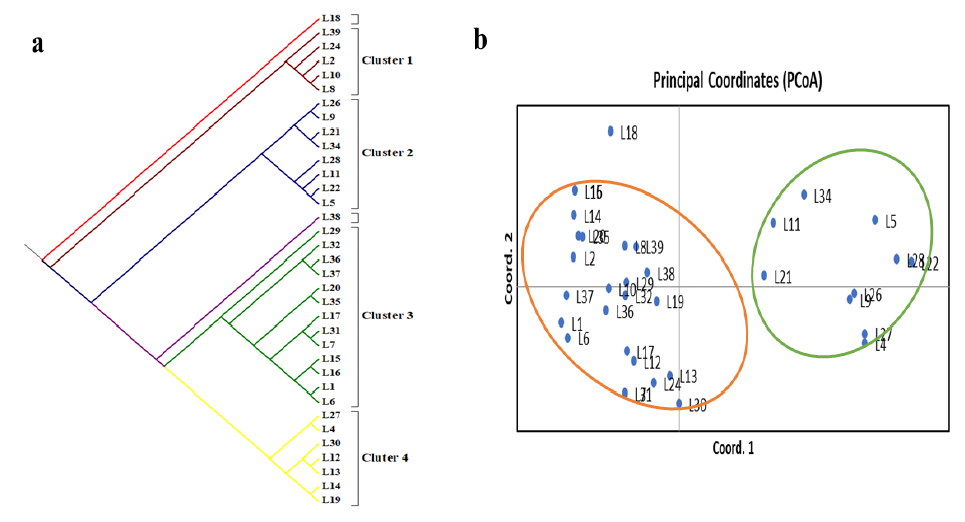
Figure 3. ( a ) Phylogenetic relationship analysis and ( b ) PCA based on 42 KASP markers.